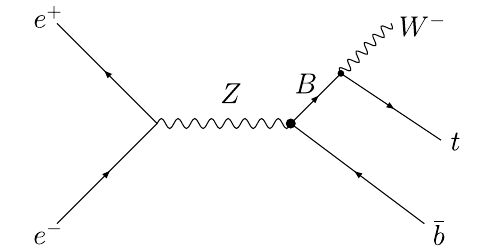
Fig. 1 Representative Feynman diagrams of the process e + e − →